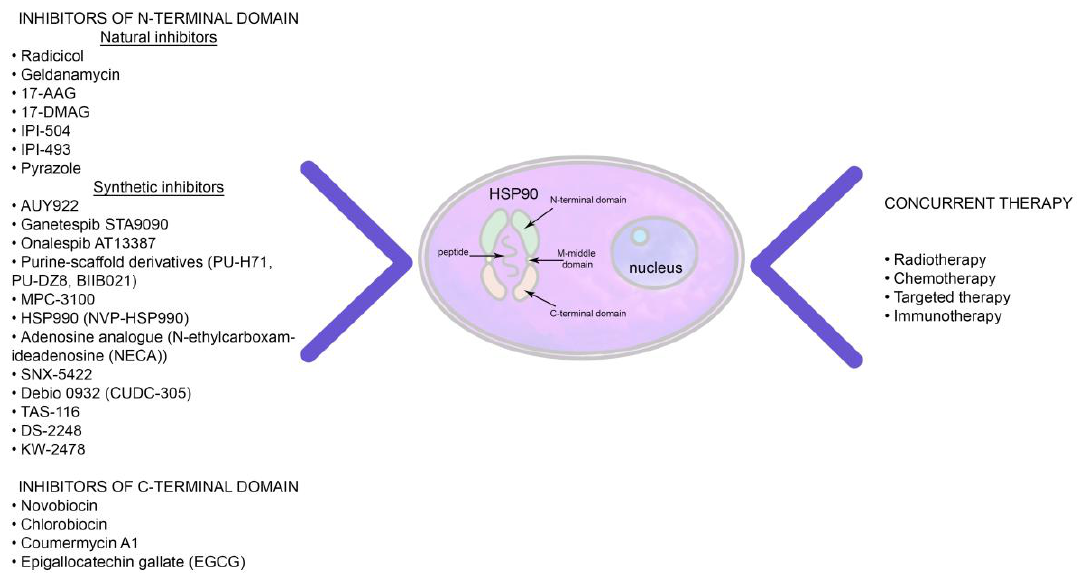
Figure 3. Concurrent application of the HSP90 inhibitors and conventional therapeutic approaches. 255